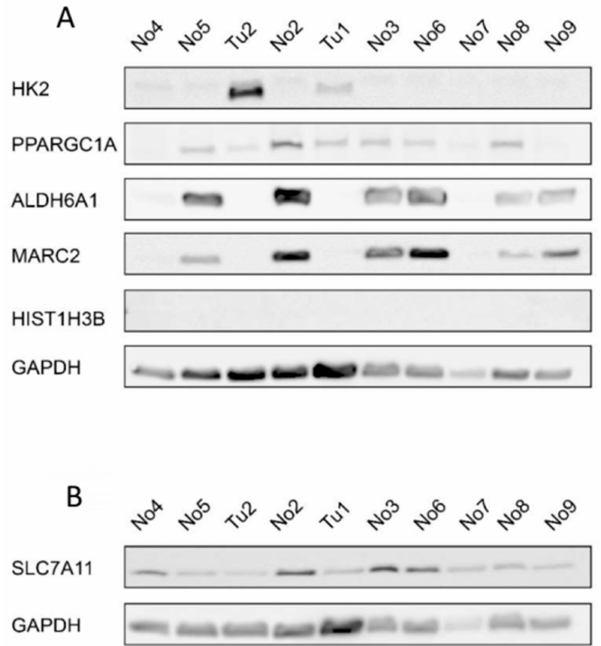
Figure 4. Protein expression of selected genes with deregulated expression in CDCs. ( A ) Western blot for HK2, PPARGC1A, ALDH6A1, MARC2, and HIST1H3B with GAPDH as the reference protein and ( B ) for SLC7A11 with GAPDH as the reference protein. Tu-tumor tissue sample; No-normal tissue